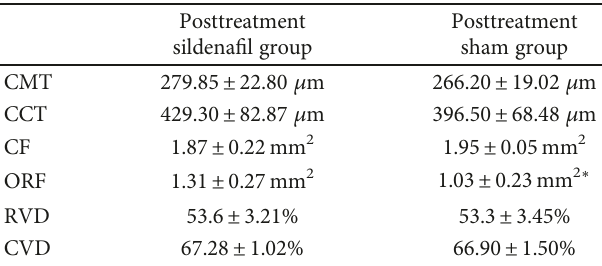
Table 2: Results after pill administration for both groups. Comparison of the variables for the study and control group 1 hour after the ingestion of sildena fi l/sham . CMT: central macular thickness; CCT: central choroidal thickness; CF: choroidal fl ow; ORF: outer retinal fl ow; RVD: retinal vascular density; CVD: choroidal vascular density. ∗ p < 0 01